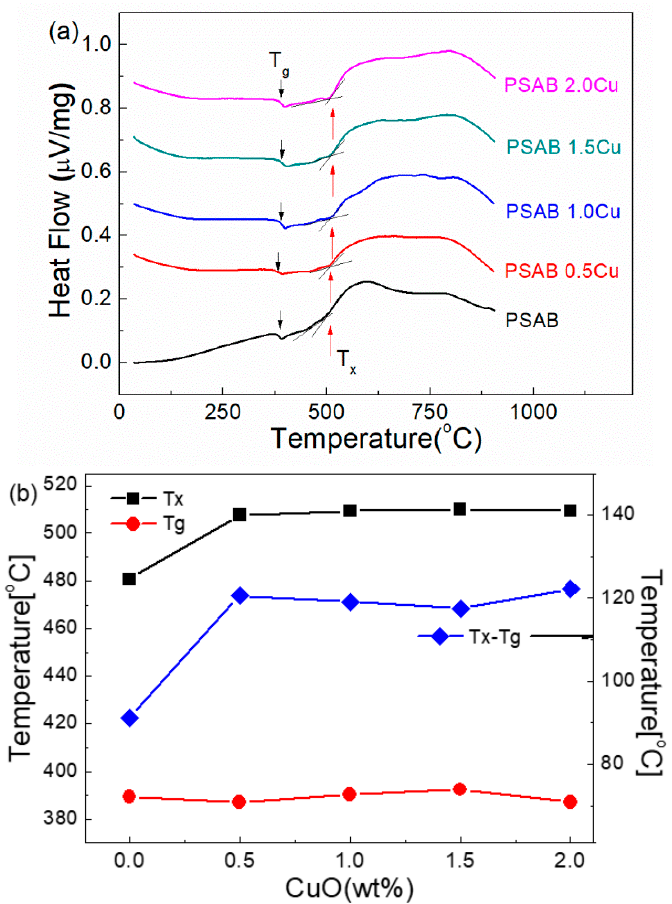
Figure 1. ( a ) Differential thermal analysis (DTA) traces; and ( b ) the quantitative values of glass transition temperature (T g ), crystallization temperature (T x ), and thermal stability ∆ T (T x − T g ) in a PbO-SiO 2 -Al 2 O 3 -B 2 O 3 (PSAB) glass system doped with various CuO concentrations.